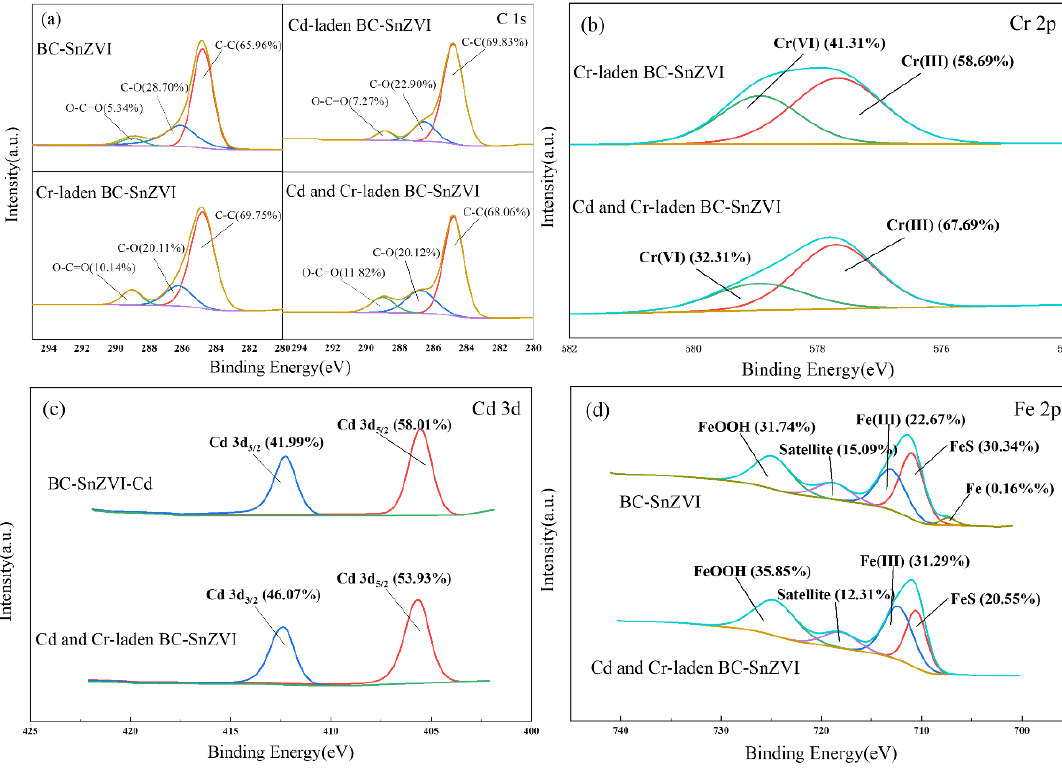
Figure 8. XPS spectra of BC-SnZVI before and after the adsorption of Cr(VI) and Cd(II): ( a ) C 1s, ( b ) Cr 2p, ( c ) Cd 3d, ( d ) Fe